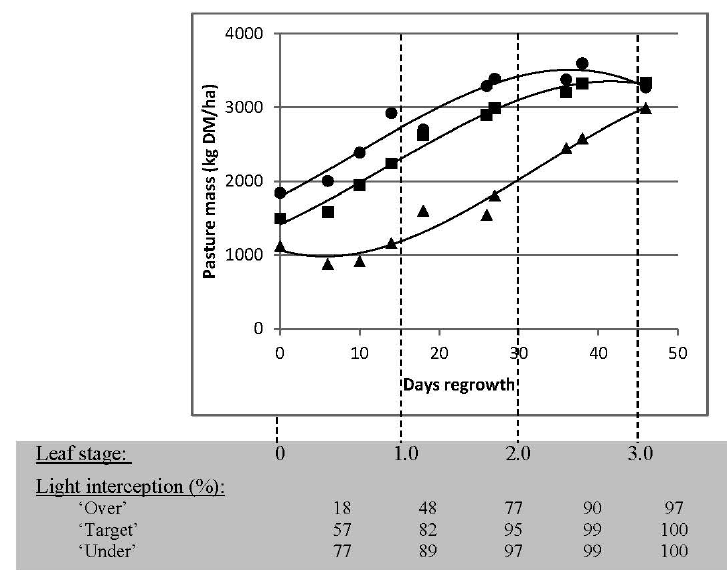
Figure 1. A single example of the regrowth of perennial ryegrass pasture following defoliation to three levels: 1150 kg ¨ DM/ha (triangles, representing “over-grazing”), 1500 kg ¨ DM/ha (squares, representing the “target” for residual state) or 1850 kg ¨ DM/ha (circles, representing “under-grazing”) kg ¨ DM/ha. Regrowth commenced on 28 March. Timing of the full emergence of the first, second and third new leaves after defoliation, and light interception, are shown below the x-axis.